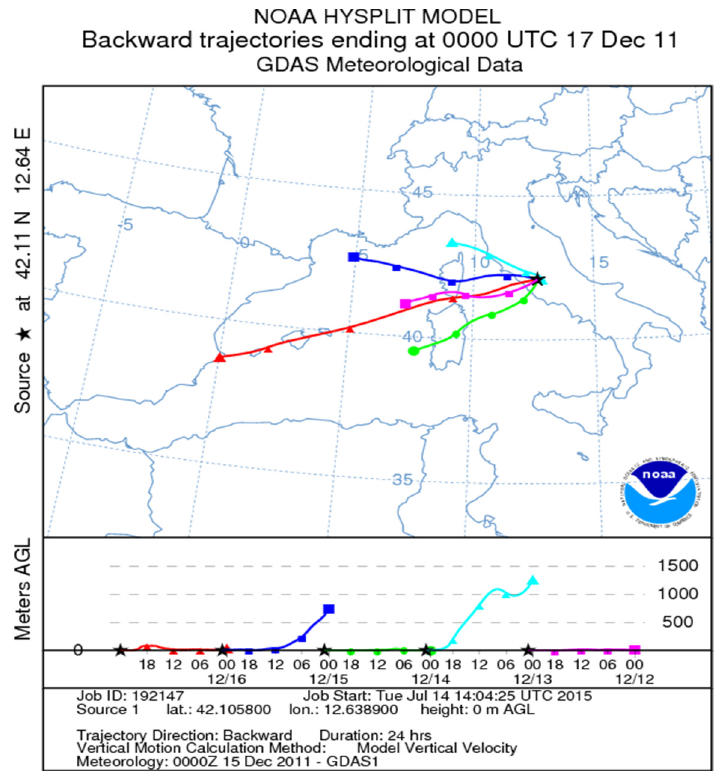
Figure A4. Backward trajectories of the air masses during 12, 13, 14, 15 and 16 December (duration 24 h). HYSPLIT model [34].